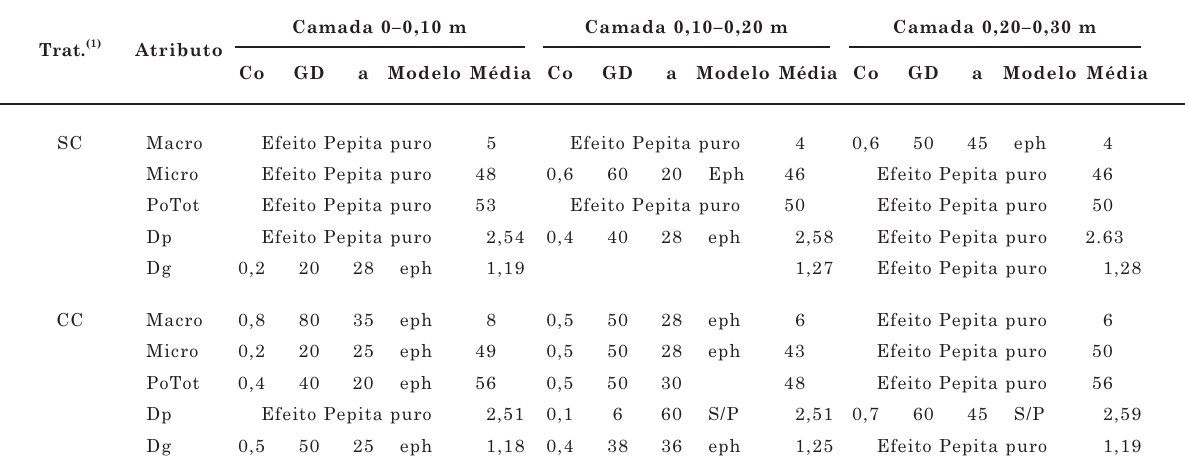
Quadro 2. Coeficientes das funções dos semivariogramas teóricos para distribuição da porosidade nas duas áreas e média de cada classe de